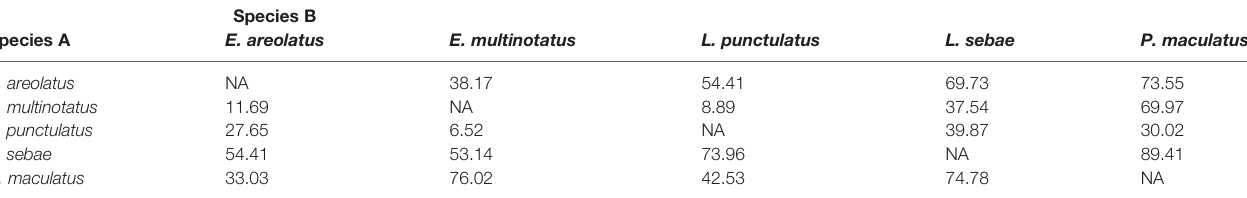
TABLE 2 | Mean probabilistic niche overlap metrics (%) for 95% niche region size for predatory fi sh. Species B Species A